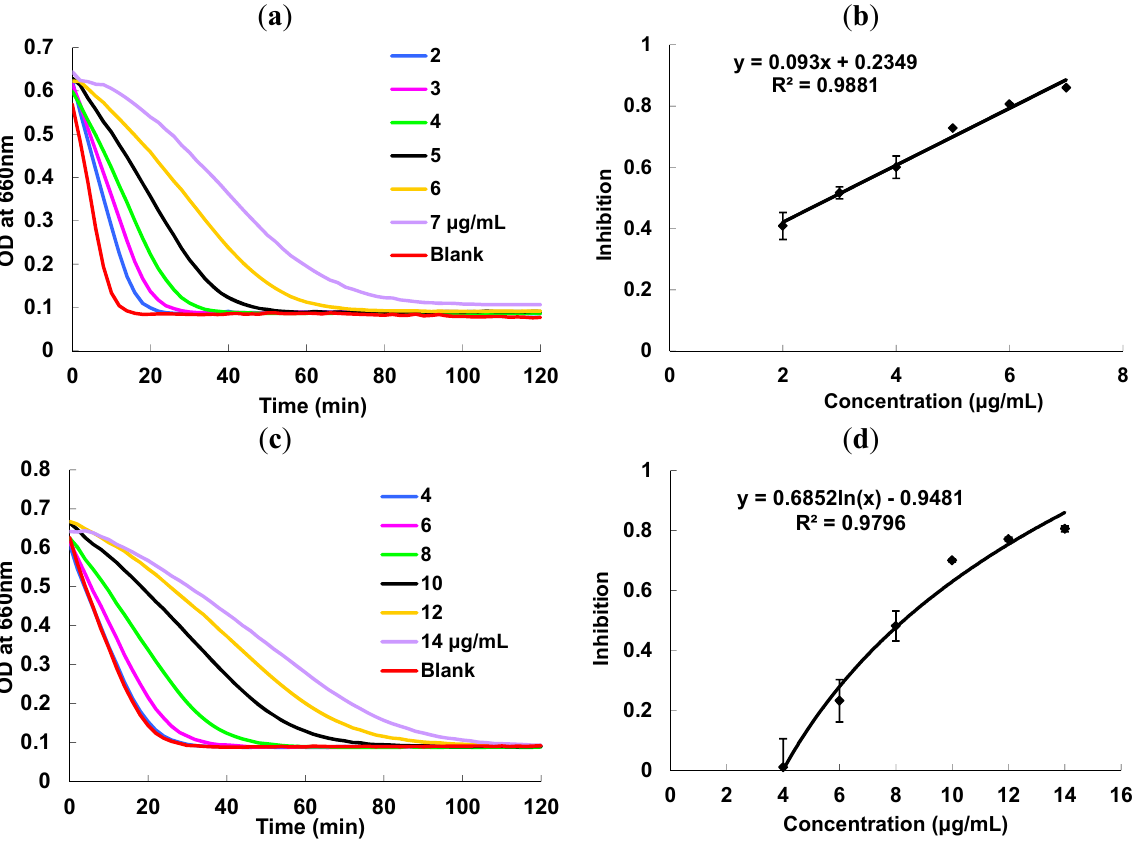
Figure 5. ( a ) Kinetic curves of α -amylase under different concentration of proanthocyanidins extract; ( b ) α -amylase inhibition activity vs. concentrations of proanthocyanidins extract; ( c ) Kinetic curves of α -glucosidase under different concentration of proanthocyanidins extract; ( d ) α -glucosidase inhibition activity vs. concentrations of proanthocyanidins